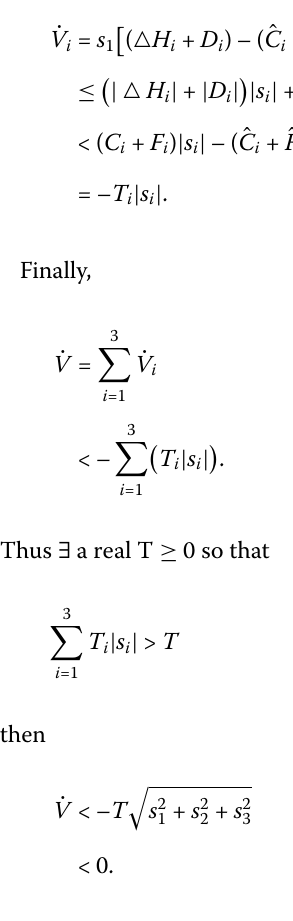
From Lyapunov stability theory (cid:6) s i (cid:6) → 0 as t → ∞ . Hence the errors converge to s i = 0 implying stability about the desired